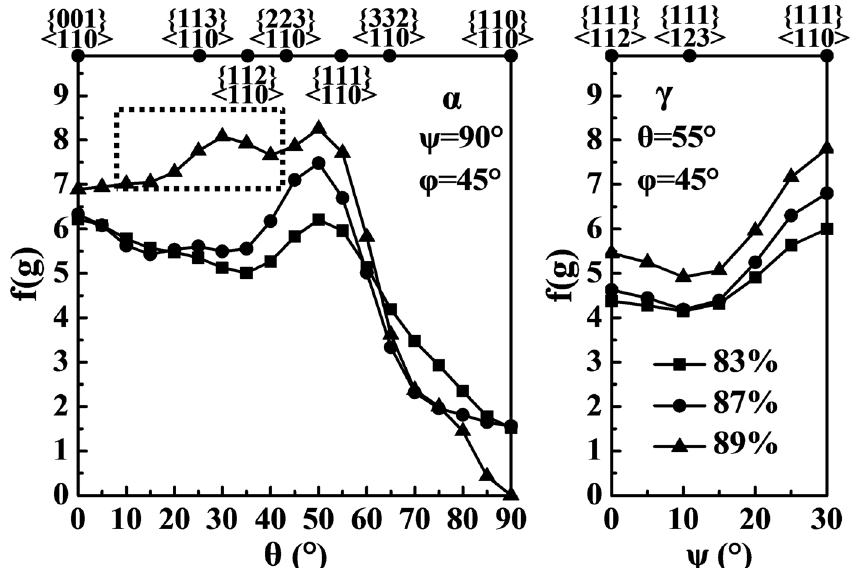
Figure 3. Orientation densities along α and γ fibers of warm rolled Fe-4.5 wt.% Si sheets under different